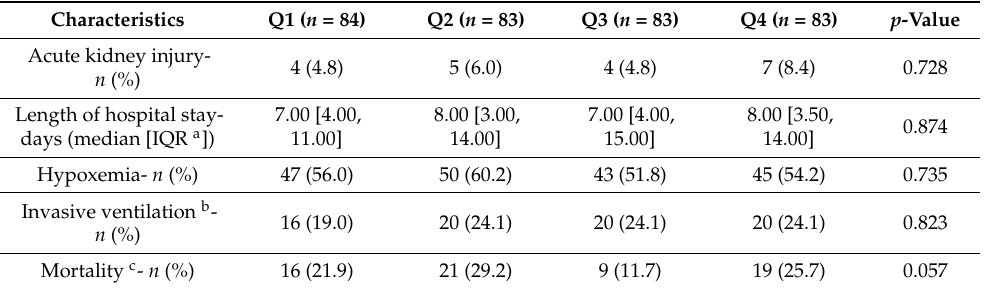
Table 5. Outcome of COVID-19 hospitalized patients according to quartiles of folate levels.